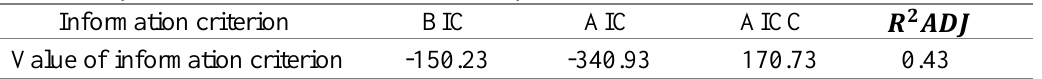
Table 4. report of information criteria for the optimal